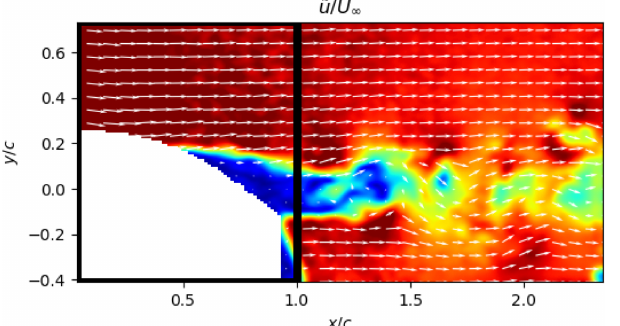
Figure 18. Reduced field of view (black rectangle) used for the third detection method using